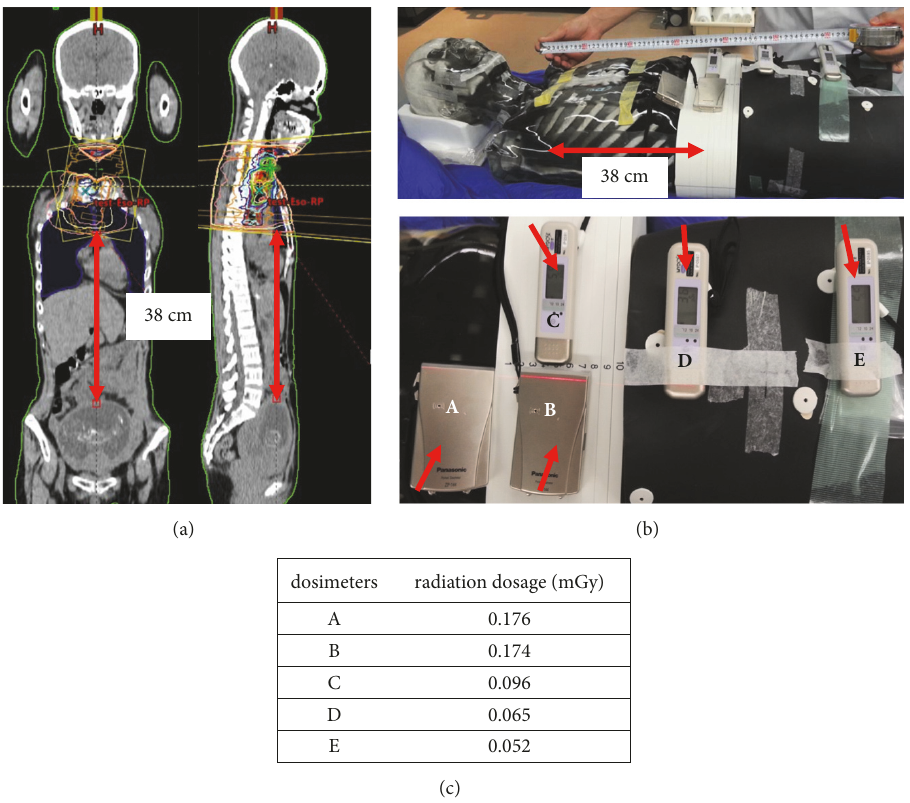
Figure 2: The simulation study of radiotherapy using a phantom. (a) The irradiation plan was created based on the recurrent lesion. The distance between the inferior margin of irradiation and the uterine fundus was 38 cm. (b) Five dosimeters (arrows) were put on the phantom’s abdomen. (c) The radiation dosage measured by five dosimeters in one irradiation fraction.